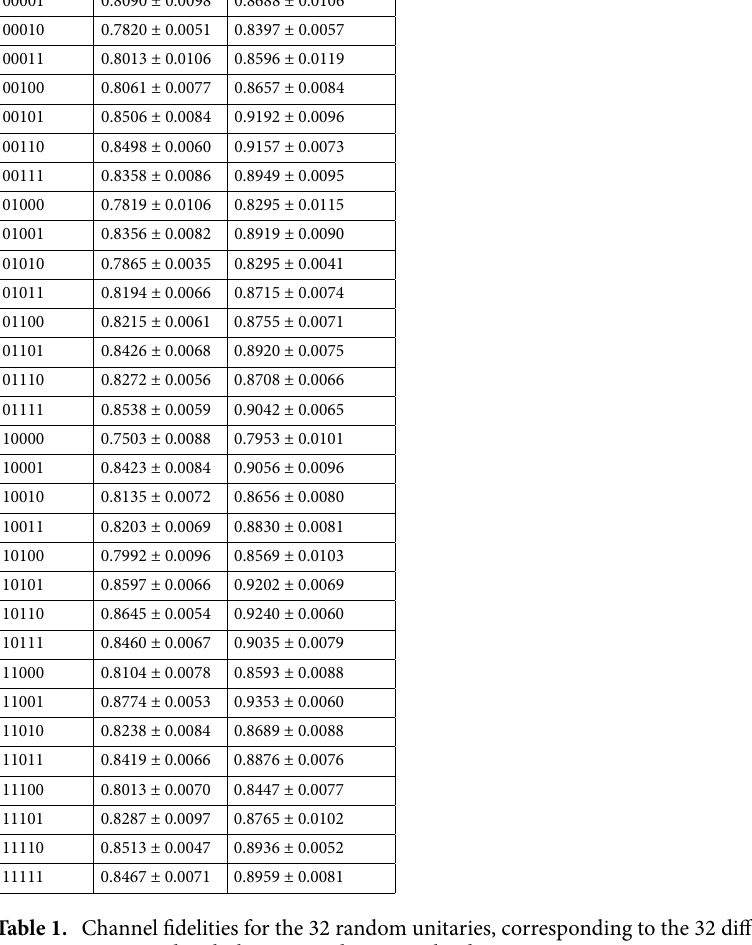
where χ ( i ) are the χ matrices determined by doing channel tomography for the different unitaries. The test amounts to generating a sample of single-qubit density matrices and finding, for each density matrix in the sample, the smallest possible ǫ such that inequality (9) is satisfied. The largest ǫ found is the one which ensures that inequality (9) is satisfied for all density matrices in the sample and is therefore the test result. 0.5 , by which we simply mean that, for the purposes of this We set the passing criterion for the test to ǫ ≤ 0.5 . In practice, some applications of paper, we consider the quality of an approximate t -design acceptable if ǫ ≤ approximate t -designs may require a smaller value of ǫ . We also note that, given an ensemble of unitaries which 0.5 , it is generally not possible to say whether this is an exact t -design or an approximate t -design with ǫ t ≤ 1 ) -design with ǫ t ensemble of unitaries is also an approximate ( t 1 ≤ 0.5 , as this depends on the ensemble. + + Therefore an ensemble of unitaries which passes our test for an approximate t -design, for a given t , may or may 1 ) -design. not pass our test for an approximate ( t + To generate a sample of single-qubit density matrices, we first generate a representative sample of points in the Bloch sphere using spherical coordinates. We generate 10 evenly spaced values of r in the range [0, 1], 10 evenly 0, π 0, 2 π) and 10 evenly spaced values of θ in the range spaced values of φ in the range . Using the standard [ ] [ conversions from spherical to cartesian coordinates, we compute r x , r y and r z for all combinations of the sampled values of r , φ and θ , thereby obtaining 1000 points in the Bloch sphere. Using